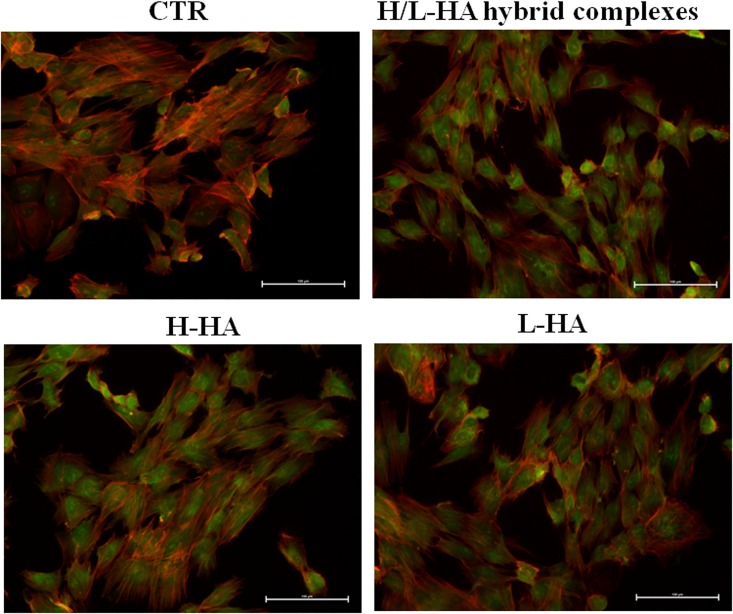
Keratinocytes-fibroblasts immunofluorescence pictures relative to ELS expression in presence of H-HA, L-HA and H/L-HA complexes 0.16% (w/w) at 24h.Green: ELS, red: Cytoskeleton (Phalloidin).